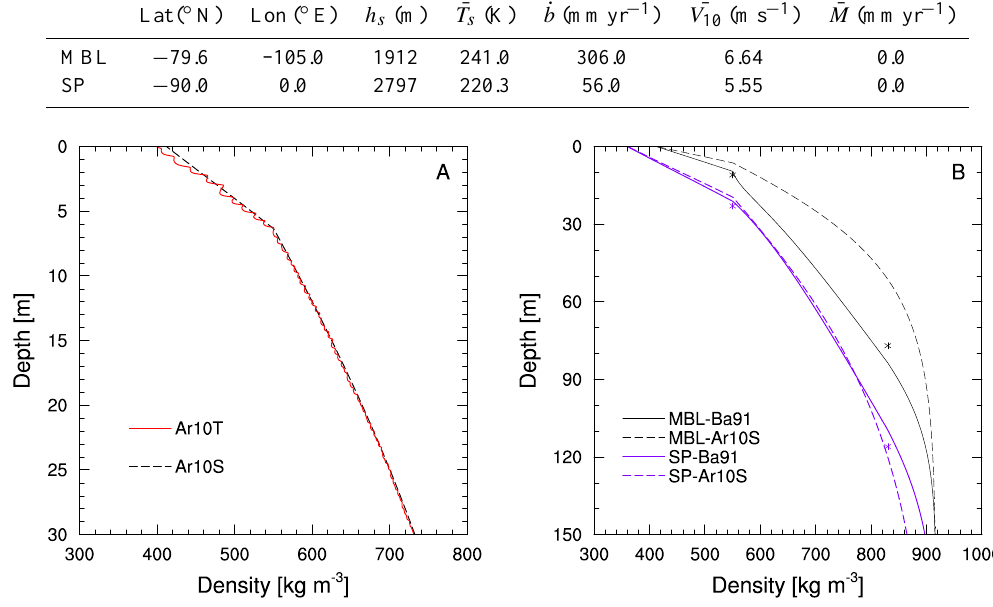
Fig. 3: Firn density profiles of the steady-state Ar10S and time-dependent Ar10T densification expressions for a location in Marie Byrd Land (A) and steady-state density profiles of Ar10S and Ba91, with the observed z 550 and z 830 (B) for South Pole (purple) and the MBL location as in Fig. A (black). Climatic characteristics of both points are listed in Table